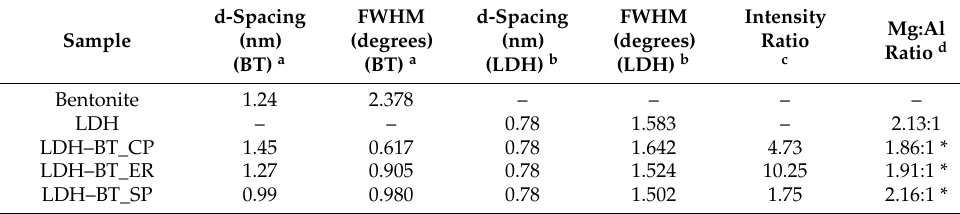
Figure 1. The PXRD patterns of ( a ) bentonite, ( b ) LDH, ( c ) LDH–BT_CP, ( d ) LDH–BT_ER, and ( e ) LDH–BT_SP (red dotted line: position of (001) from bentonite, blue dotted line: position of (003) from LDH). Table 1. Detailed characterization results from the PXRD and elemental